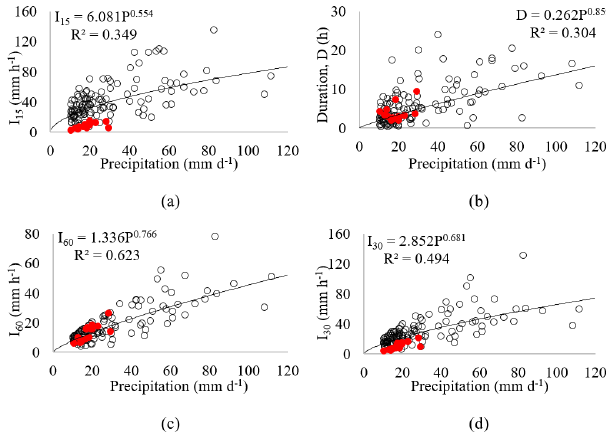
Figure 4. Correlation between daily precipitation and sub-daily variables at the Aiuaba experimental basin (Figueiredo et al., 2016). (a) Daily precipitation versus event duration ( D ); (b) daily precip- itation versus 60min maximum intensity ( I 60 ); (c) daily precipita- tion versus 30min maximum intensity ( I 30 ); and (d) daily precip- itation versus 15min maximum intensity ( I 15 ). The white circles indicate data obtained in Aiuaba from 2005 to 2014. The red dots in- dicate precipitation measured in the Madalena representative basin (MRB) from January to July 2019 (rainy